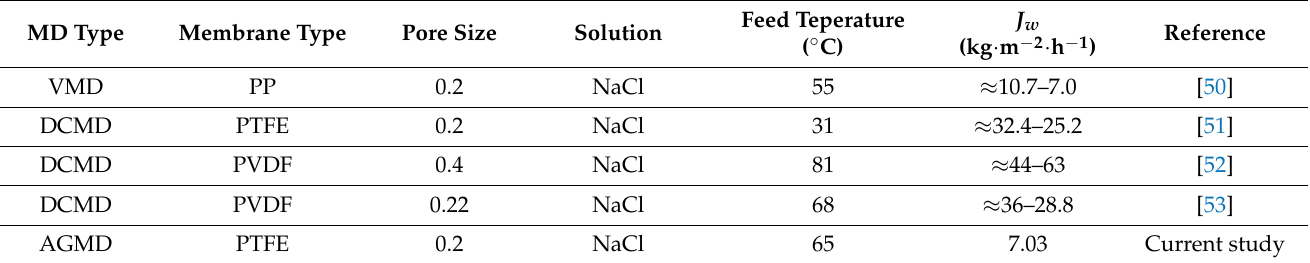
( b ) Temperature Figure 6. Instantaneous variation of solar radiation and ambient temperature (Ghardaïa site).